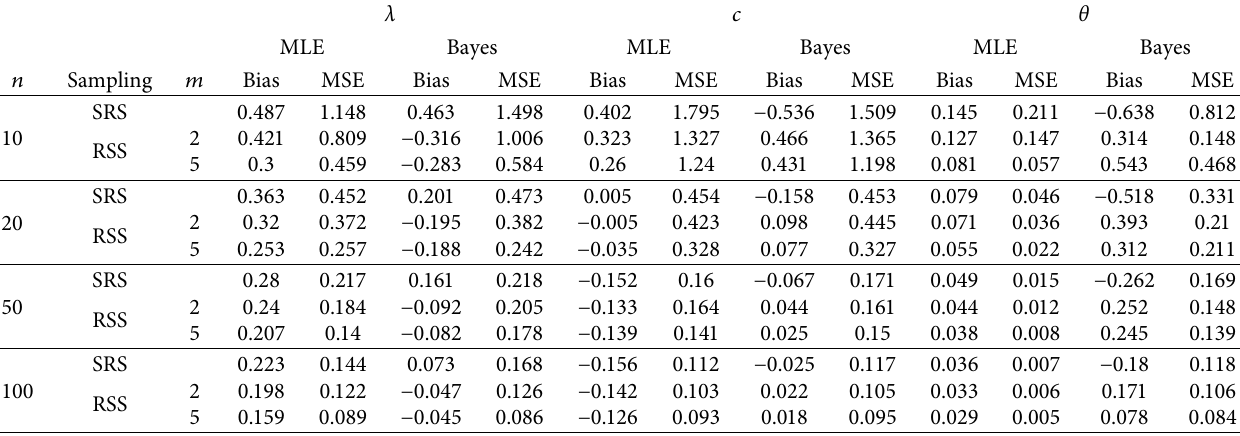
Table 3: Bias and MSE of the Bayes estimates obtained using DE-MCMC and Lindely methods under RSS and SRS for different sample sizes